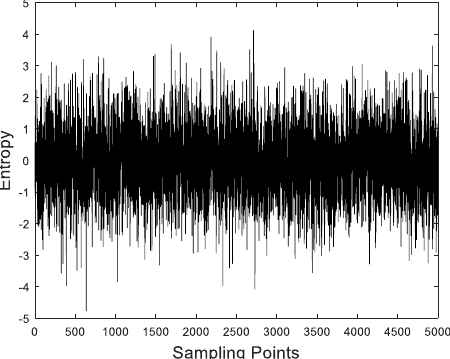
Figure 1. White Gaussian noise used in multiscale permutation entropy (MPE) and improved multiscale permutation entropy (IMPE) simulation.